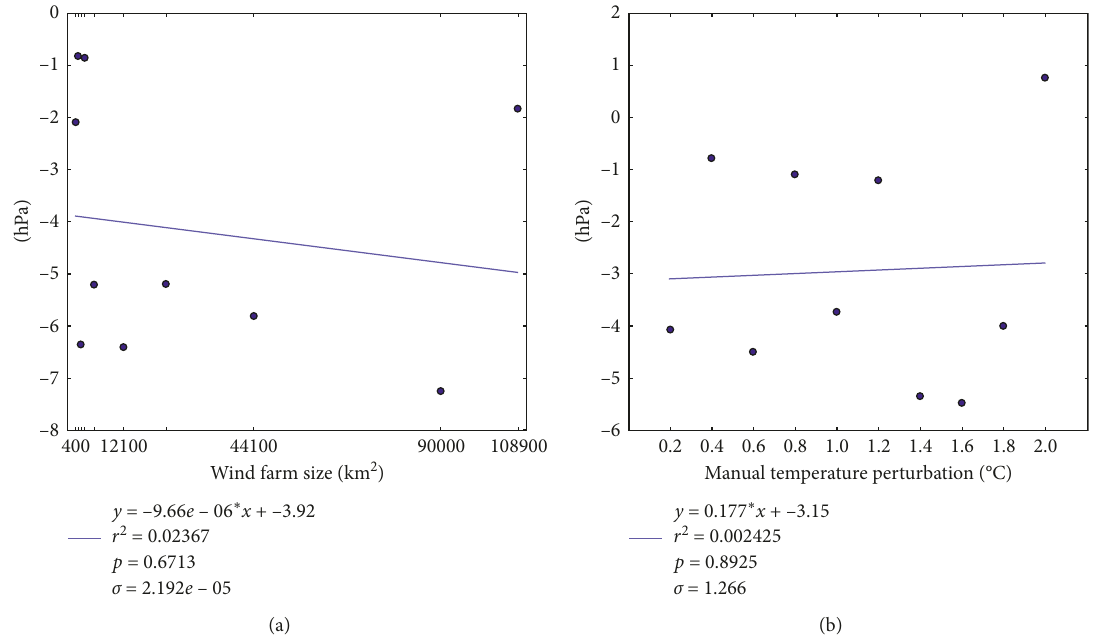
Figure 15: Largest perturbation of cyclone minimum sea-level pressure for the ten wind farm sizes (a) and unrealistic effects ensemble (b) for the 3 October 2013 tropical cyclone case.